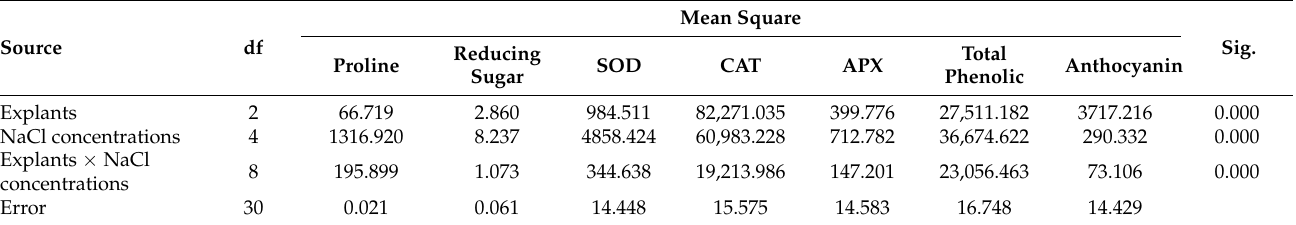
Table 5. Analysis of variance to assess the impacts of NaCl concentrations, explants, and their interaction on compatible osmolytes, antioxidant enzyme activity, and secondary metabolites in the seedlings, calli, and regenerated seedlings of Carum